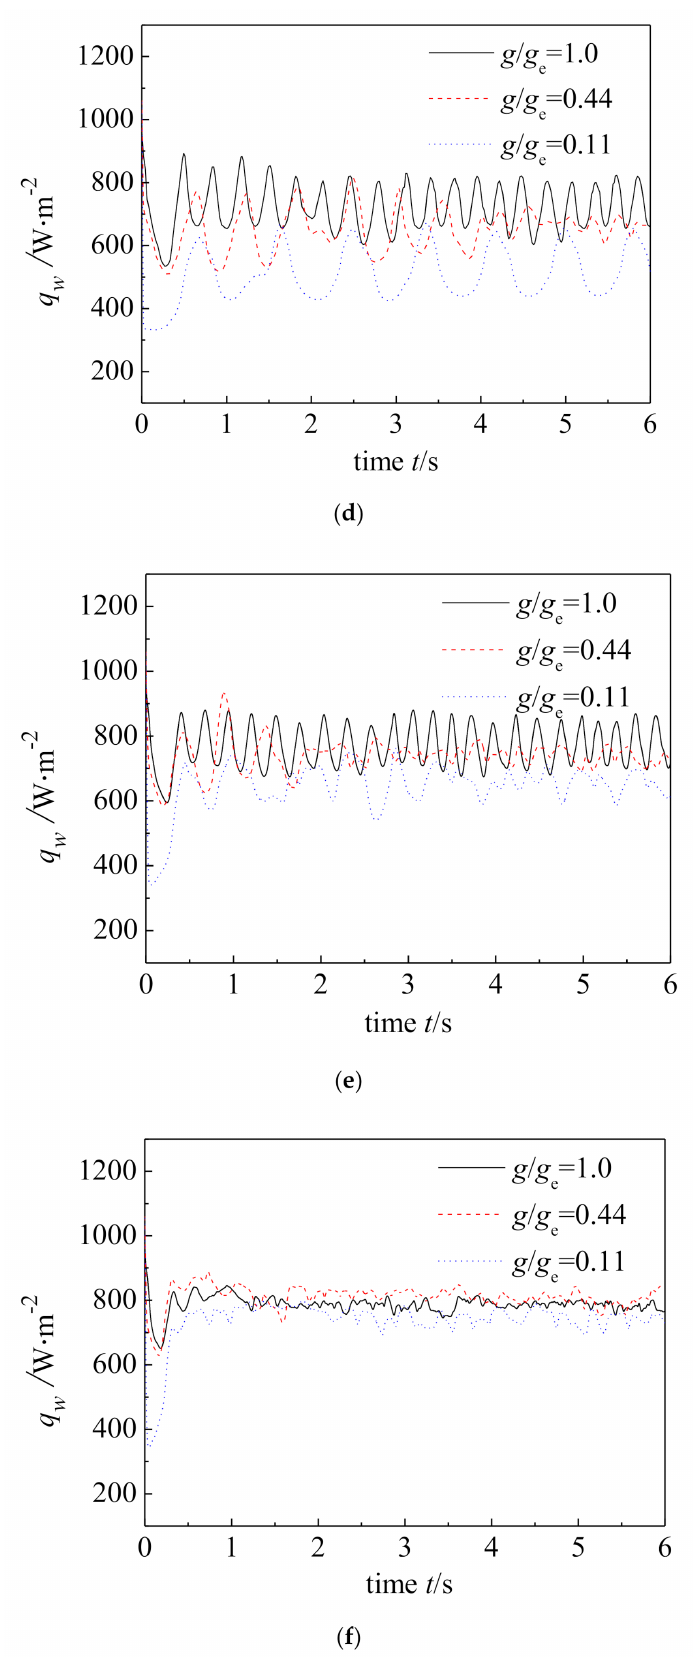
Figure 15. Influence of the magnetic field intensity on the variation of the space-averaged heat flux in different gravity conditions. ( a ) H0 = 0 kA/m, ( b ) H0 = 5 kA/m( c ) H0 = 10 kA/m, ( d ) H0 = 15 kA/m, ( e ) H0 = 20 kA/m, and ( f ) H0 = 25